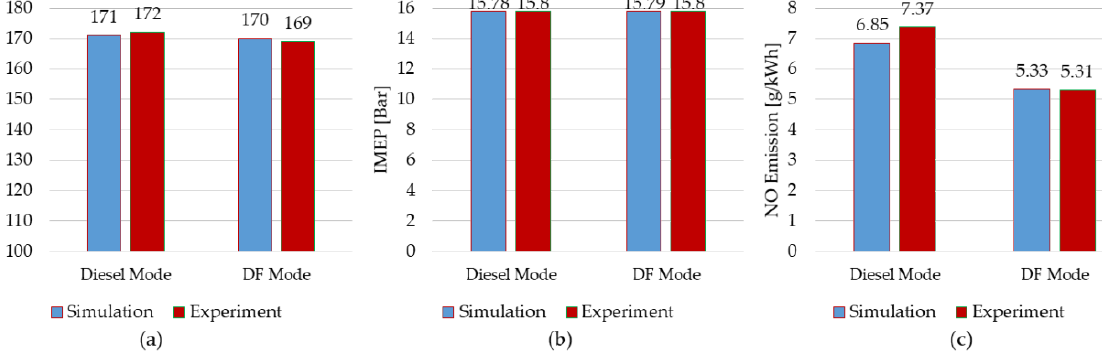
Figure 6. Comparison between the simulation and experimental results: ( a ) Peak pressure; ( b ) IMEP; ( c ) NO emission.